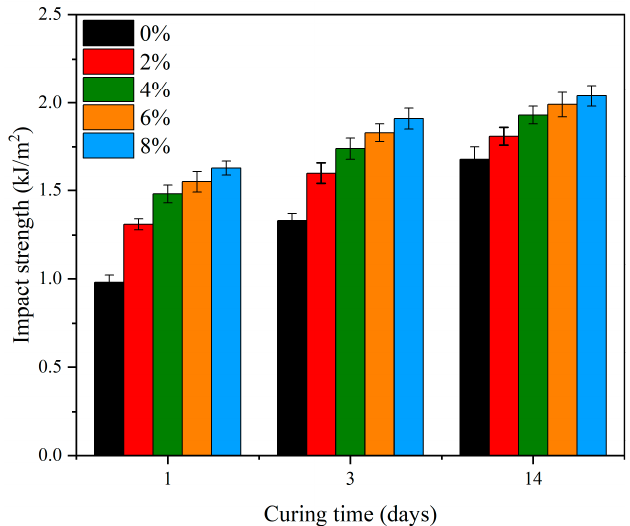
Figure 6. Impact strength of cement samples with ultrafine calcium